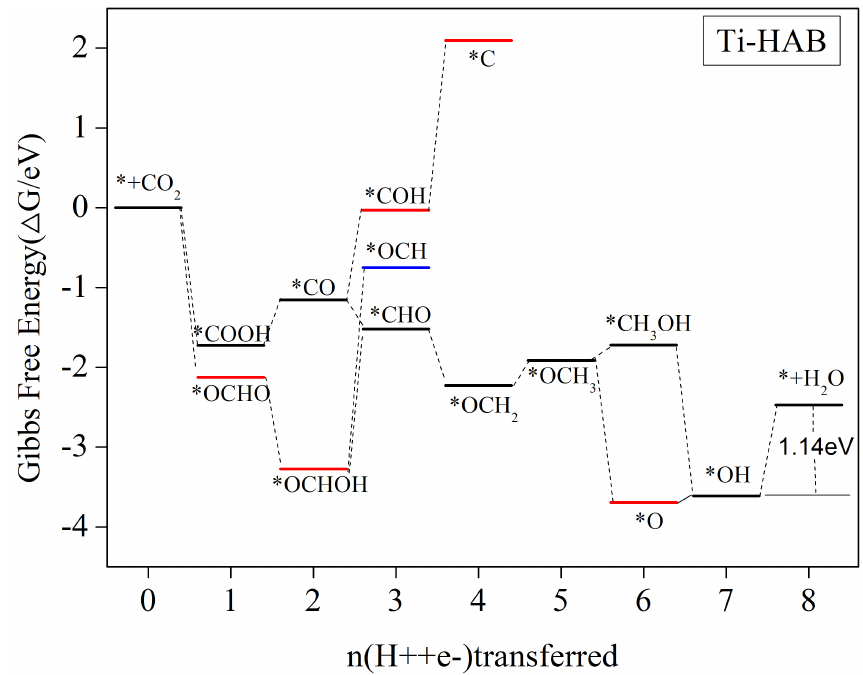
Figure 9. Gibbs free energy curve of CO 2 RR along the most favored path of Ti-HAB at zero potential. The free energy zero has been set as the free energy of CO 2 molecules in the gas phase with a clean catalyst